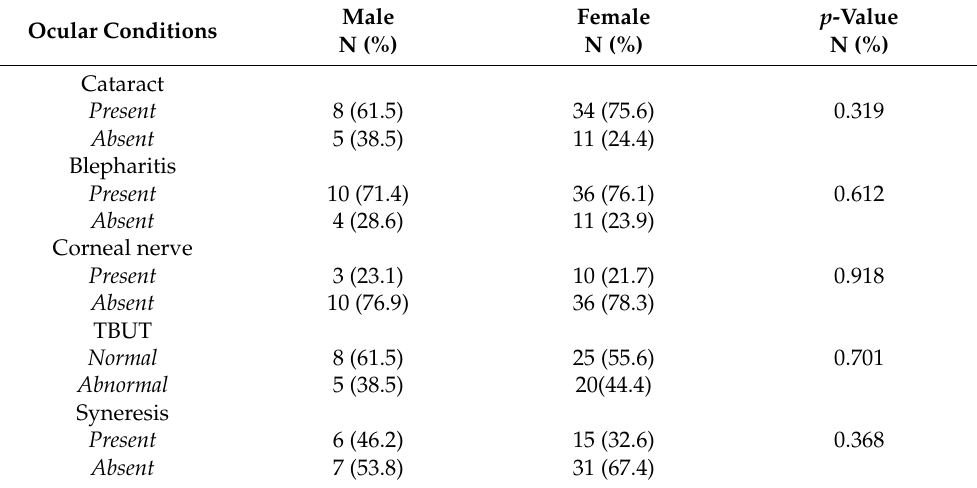
Table 4. Distribution of subjects according to association between ocular changes and sex of children and adolescents with diabetes mellitus, N =